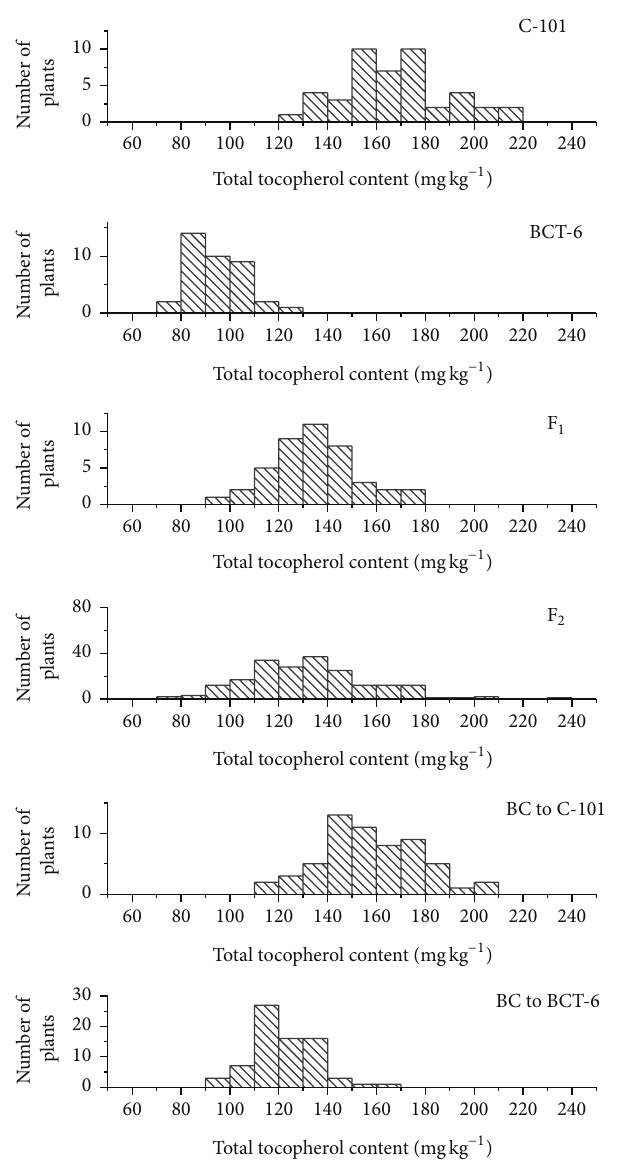
Figure 2: Histograms of total tocopherol content (mgkg −1 seed) in the Ethiopian mustard lines C-101 and BCT-6 and the F 1 , F 2 , and BC generations derived from their cross.